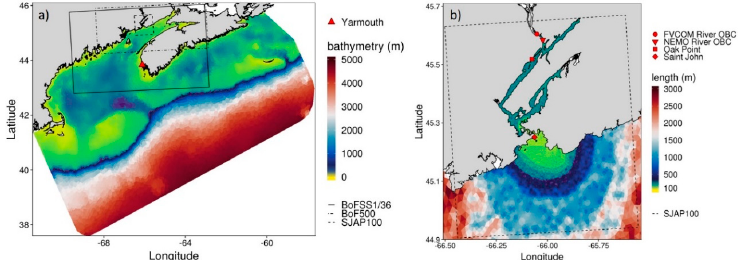
Figure 2. ( a ) Bathymetry over the FVCOM (Finite Volume Coastal Ocean Model) grid and the outlines of the Bay of Fundy and the western Scotian Shelf model component with a nominal horizontal resolution of 1/36-degree (BoFSS1/36) (solid line), the Bay of Fundy model component with an approximate 500 m resolution (BoF500) (dash-dot line), and the inner and outer Saint John Harbour model component with an approximate 100 m resolution (SJAP100) (dashed line) model domains. ( b ) Colormap showing the variable resolution of the FVCOM (as element side length in m) with the outline of the SJAP100 model domain (dashed line). Location of the river boundary, where the open boundary condition (OBC) is applied, is shown for the FVCOM (circle) and NEMO (Nucleus for European Modelling of the Ocean) (inverted triangle). Yarmouth (triangle), Saint John (diamond) and Oak Point (square) are marked for reference. The structured-grid of NEMO does not have the flexibility to vary the horizontal grid size greatly with a single design. Instead, the approach taken was to develop three configurations (shown in Figure 2a) that are connected with one-way nesting. The grids of the three components are all aligned with the tri-polar ORCA grids created by the DRAKKAR Group [34], [25]. The outer component covers the Bay of Fundy and the western Scotian Shelf with a nominal horizontal resolution of 1/36- degree, hence referred to as BoFSS1/36. The intermediate component covers the Bay of Fundy with an approximate 500 m resolution (hereafter BoF500). The inner component covers the inner and outer harbour with an approximate 100 m resolution (hereafter SJAP100). Note that the Saint John river estuary system, including the Reversing Falls, is included in SJAP100, roughly represented in BoF500, but totally excluded in BoFSS1/36. The one-way nesting is achieved by the larger domain component